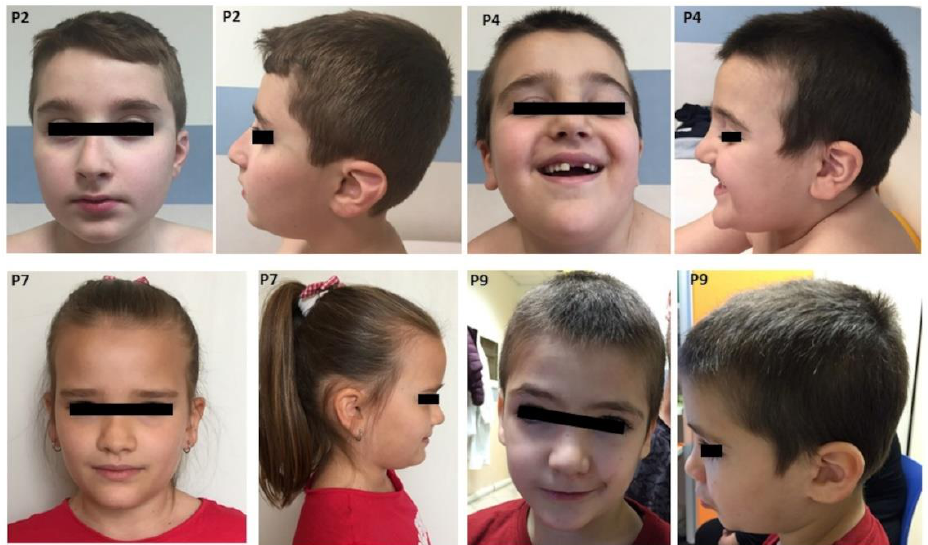
detected in our 10 patients.